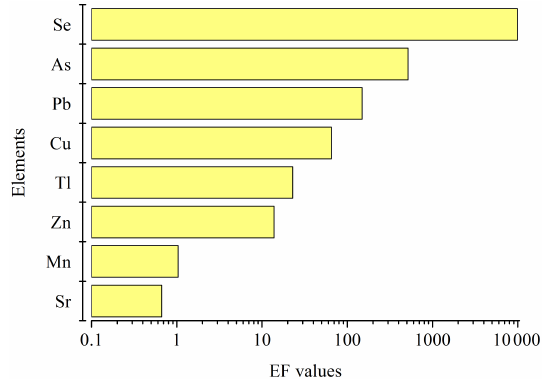
Figure 2. Enrichment factor values for trace elements in PM 2 . 5